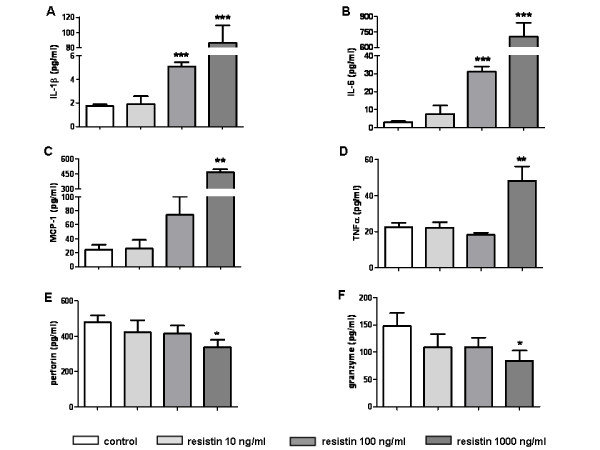
Effects of resistin on peripheral blood mononuclear cells (PBMC). Resistin induces the release of IL-1α (a), IL-6 (b), MCP-1 (c) and TNFα (d) and reduces the release of perforin (e) and granzyme (f) from PBMCs into cell culture media after 48 hours. Bars represent the mean + SEM. P-values less than 0.05 were considered statistically significant; * P < 0.05,** P < 0.01, *** P < 0.001.